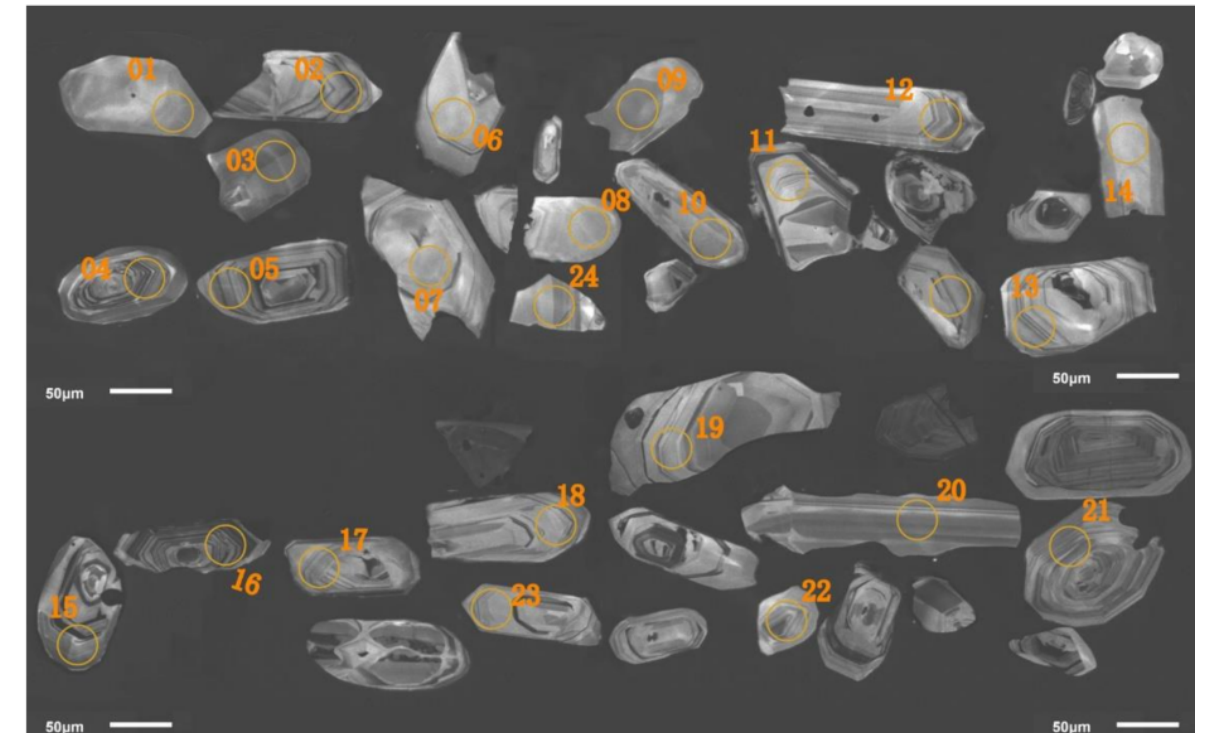
Figure 10. Cathodoluminescence (CL) images of zircons from samples of LA-ICP-MS U–Pb analyses.